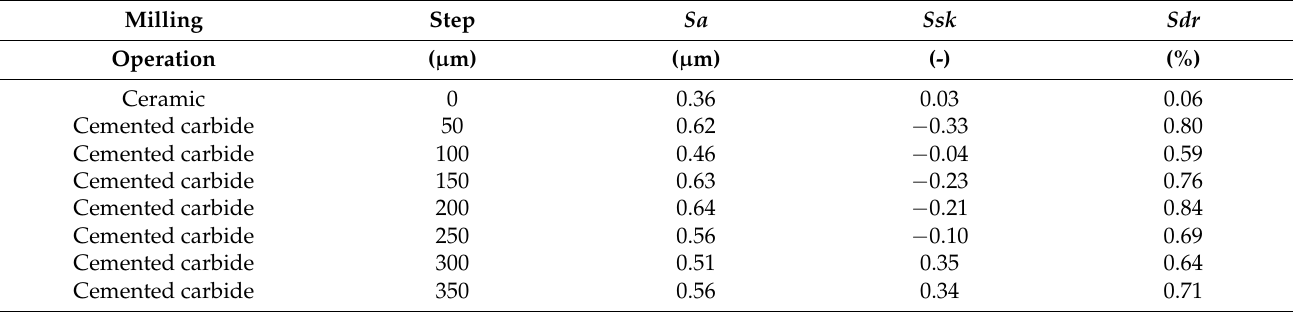
Table 4. Topography results for the ceramic and cemented carbide milled steps after 50–350 µ m milling.